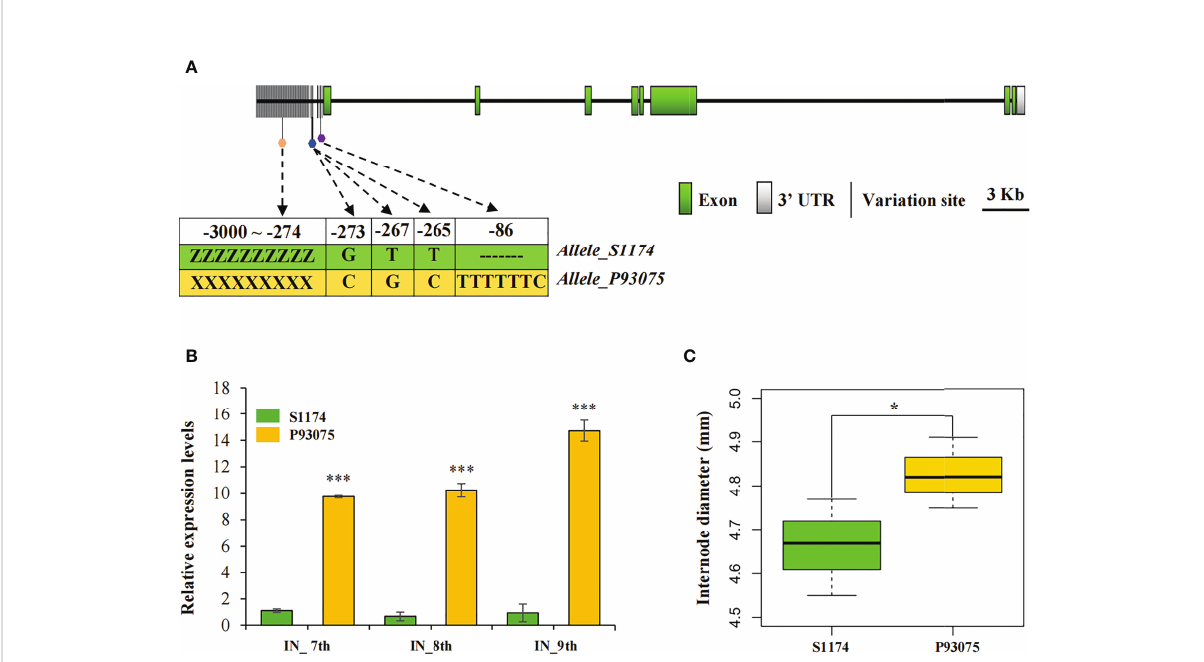
FIGURE 3 Candidate gene LacCRWN3 targeted by qID2 responsible for internode diameter. (A) Schematic representation of the structure and sequence variations of LacCRWN3 . The white box represents the 3 ’ un-translated region (UTR), and the green boxes represent exons. The upstream region before the fi rst exon indicates the 5 ’ UTR and promoter region. The vertical black lines indicate variations between S1174 and P93075 in the upstream region. The pentagons represent variation sites in the major cis-elements, different colors indicate different cis-elements. ZZZZZZZZZ and XXXXXXXXX refer to completely different allelic sequences in the region -3000 to -274 upstream of the start codon ATG. Variations of the marked sites between alleles from S1174 and P93075 are displayed in green and yellow backgrounds, respectively. (B) Expression pro fi les of LacCRWN3 in the 7th, 8th, and 9th internode of parental lines S1174 and P93075. (C) Phenotypic variation of internode diameter between parental lines S1174 and P93075. Results indicate mean ± SE of three replicates, *** P < 0.001; * P <